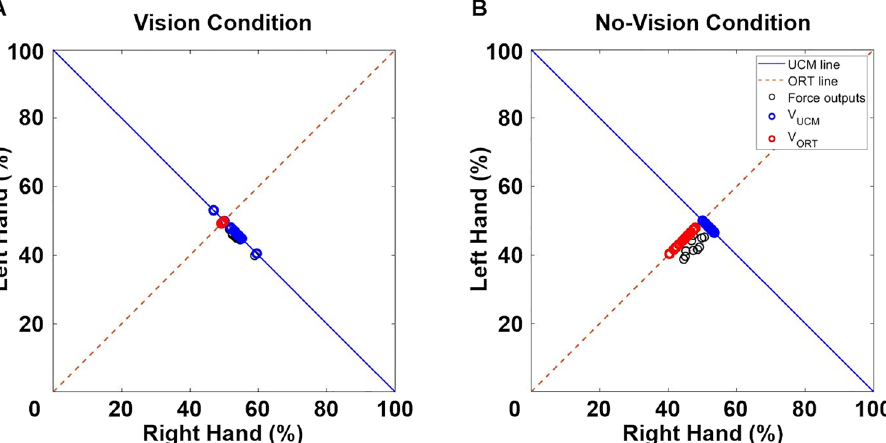
Figure 5. Representative UCM data quantifying variances of fundemental elements projected to the UCM and ORT lines. ( A ) The 12 pairs of nomalized fundamental elements extracted from each trial (i.e., black circles) projected to both UCM line (i.e., blue line) and ORT line (i.e., dotted red line) at 25% of MVC condition in the vision condition and ( B ) No-vision